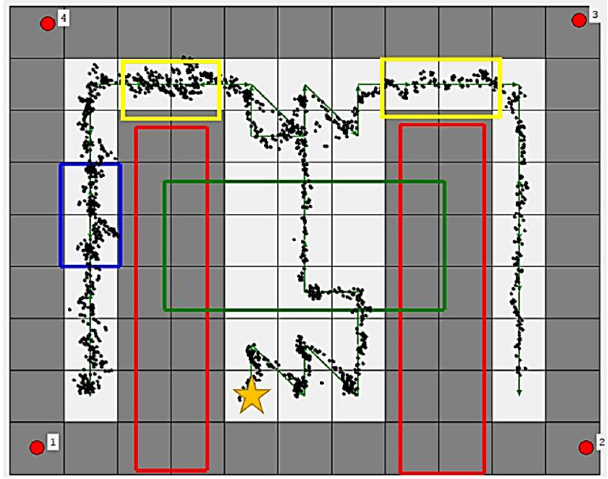
Figure 12. The planned path and positioning results in the experiment. The green arrows represent the path and its direction.